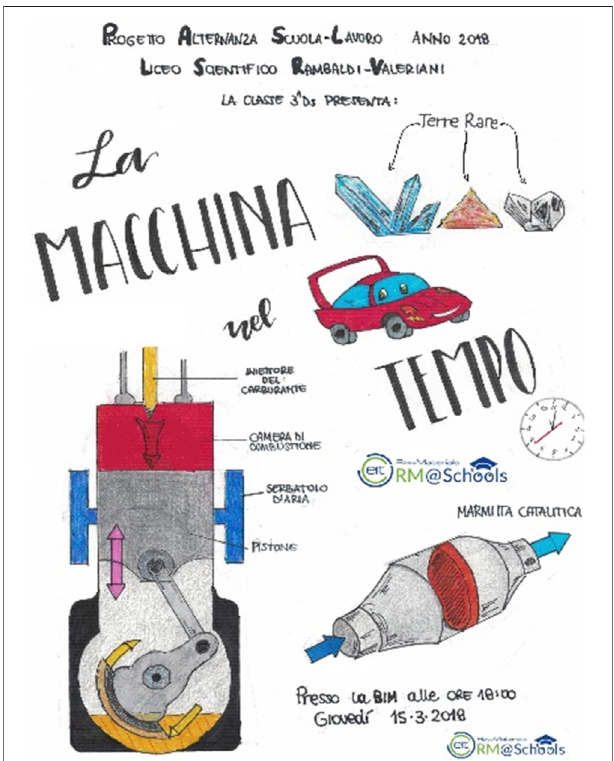
FIGURE 5 | Hand-drawn fl yer of the live event “ The time machine ” presented by Class 7 at